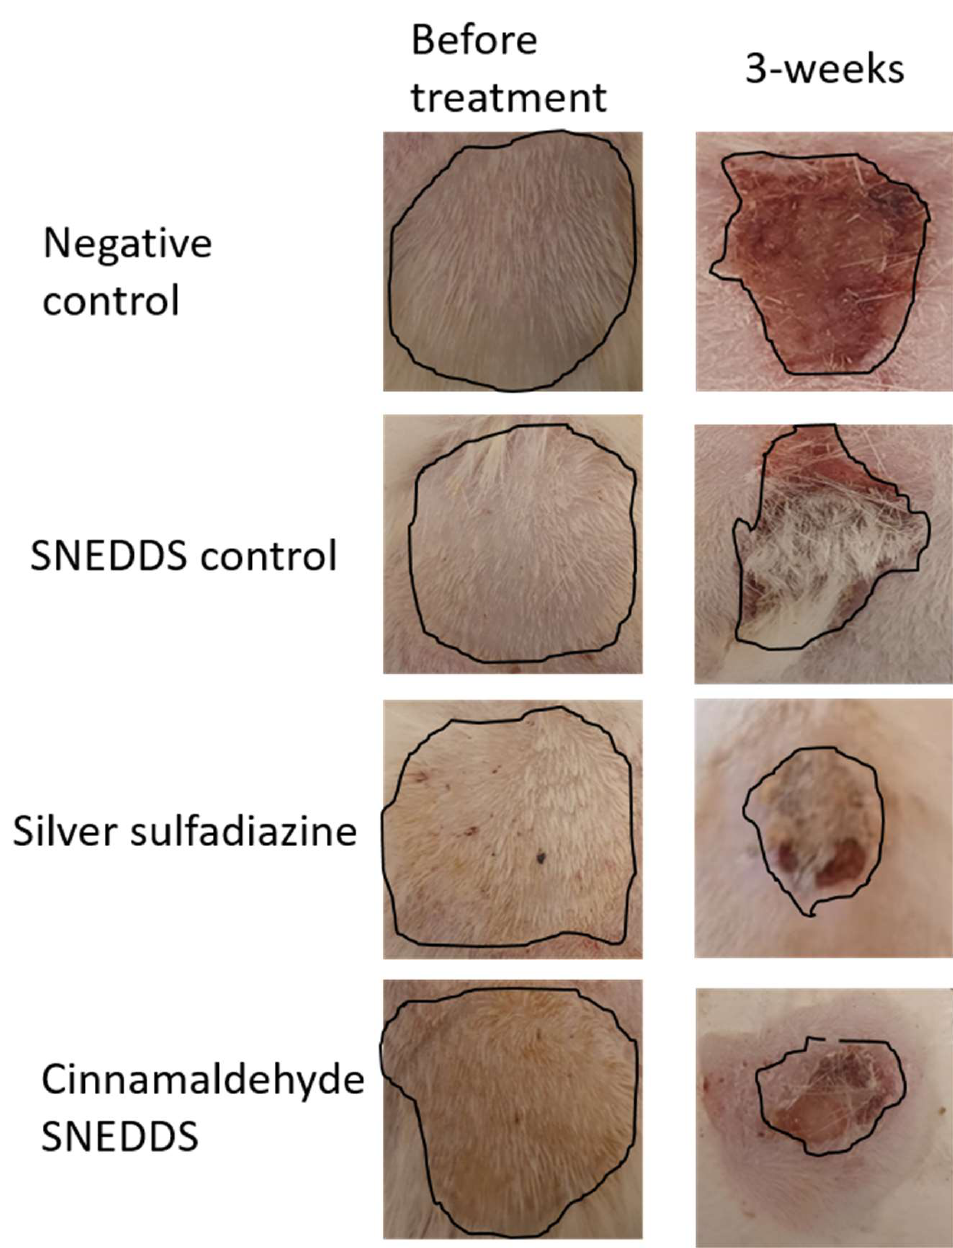
Figure 4. Morphological appearances of the negative, SNEDDS control, silver sulfadiazine, and cinnamaldehyde SNEDDS groups at the time of skin burn induction and the end of the experi- mental procedure. Image markings in black indicate the wound area for all the groups before and after treatment. areas measured for all the groups were not statistically different, while at the end of the experiment, after 3 weeks, the treated groups, SS and CA-SNEDDS, were significantly dif- ferent, while SNEDDS control did not differ significantly when compared to the untreated group ( p < 0.05) (Figure